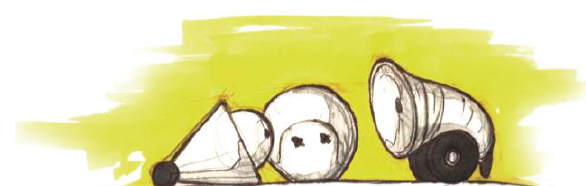
Figure 3 | A sketch about a preliminary idea of a robot’s family.